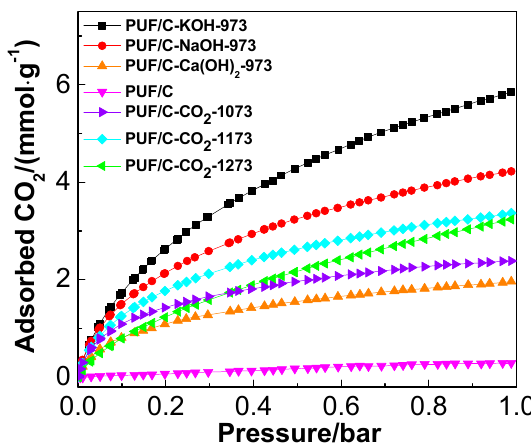
Figure 9. Adsorption isotherms of CO 2 at 273 K for the studied samples.